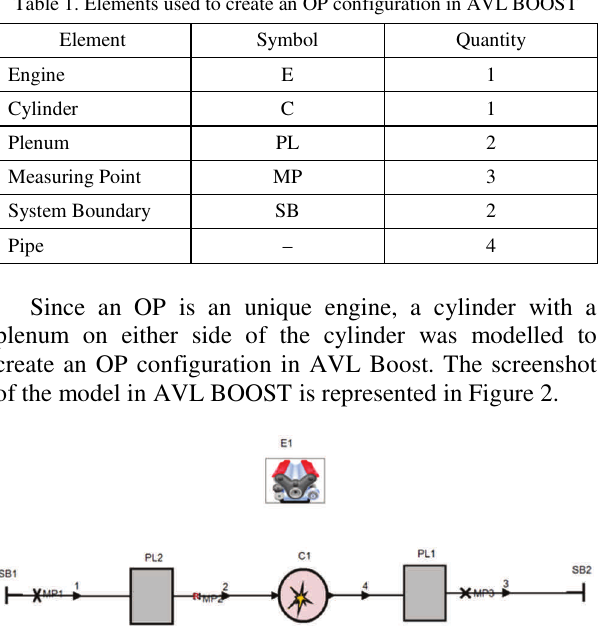
Fig. 2. Screenshot of the model in AVL